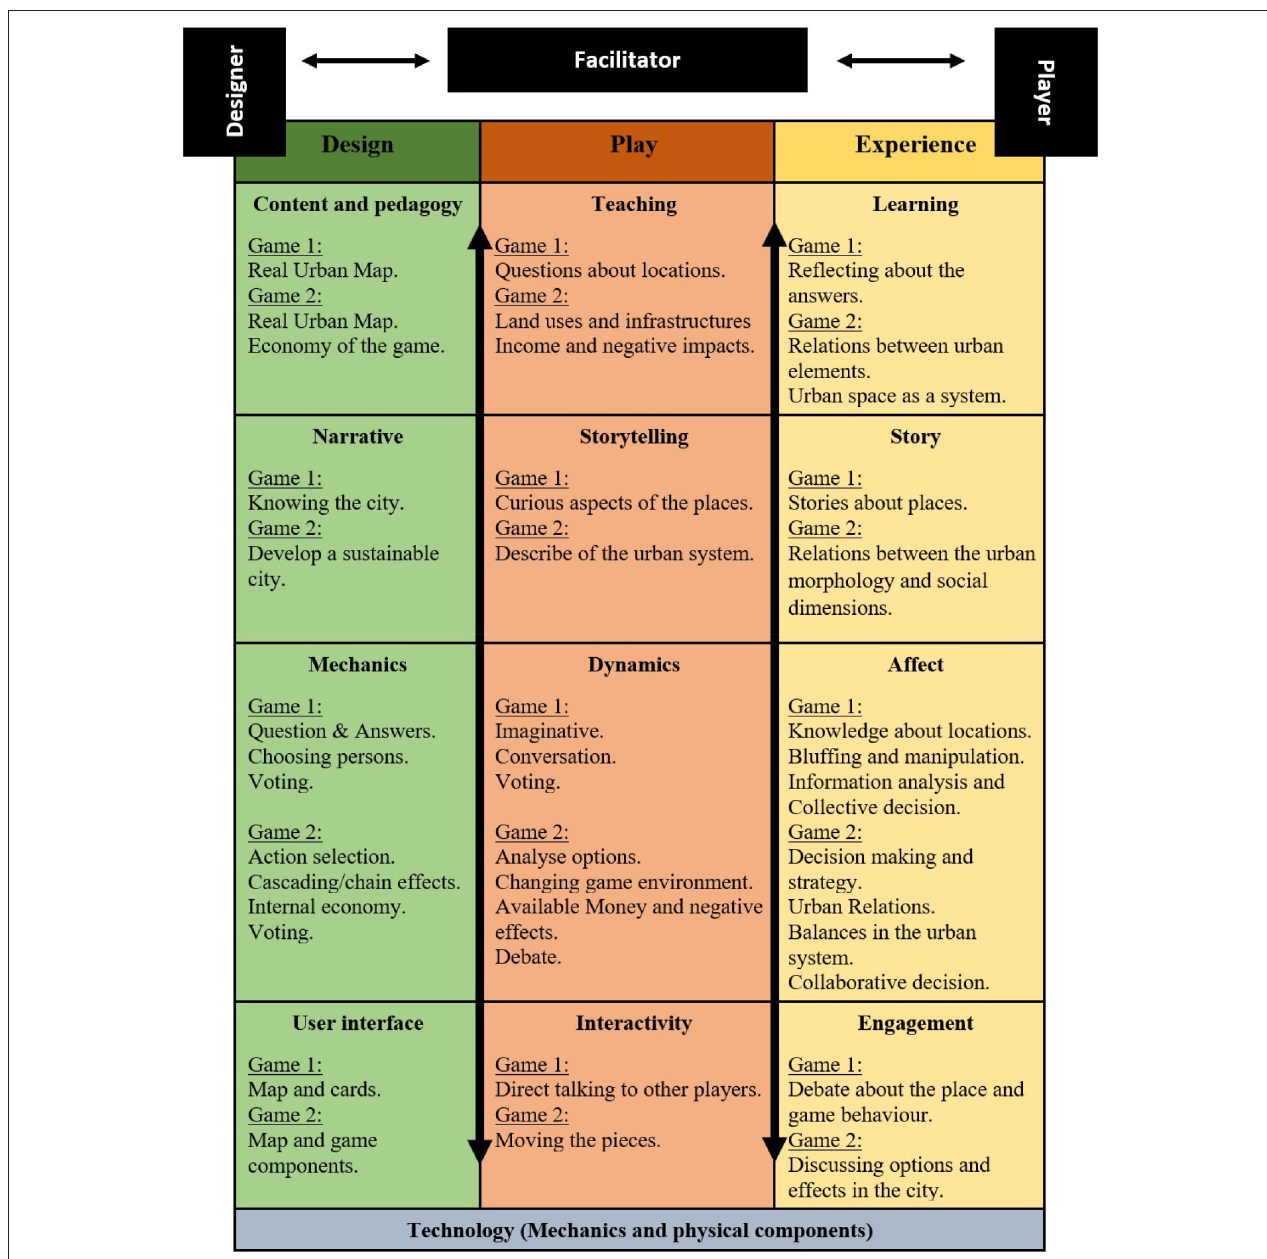
FIGURE 1 | DPE framework adapted to the serious game process of analog